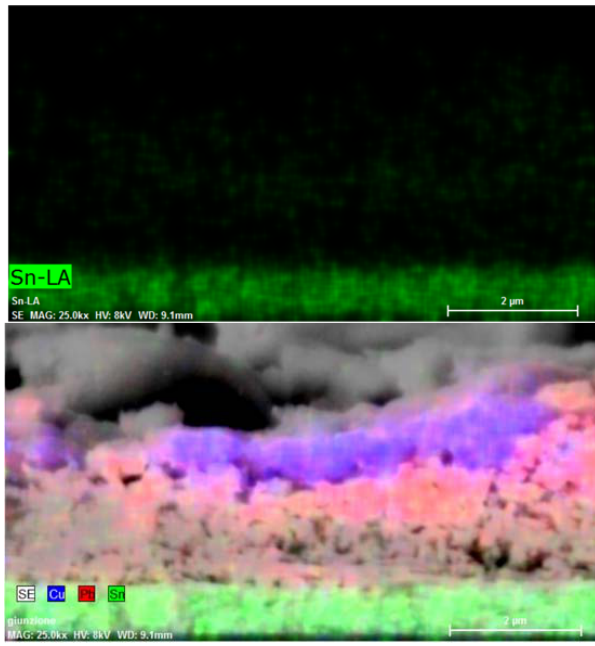
Figure 5. EDS microanalysis maps of the heterojunction.